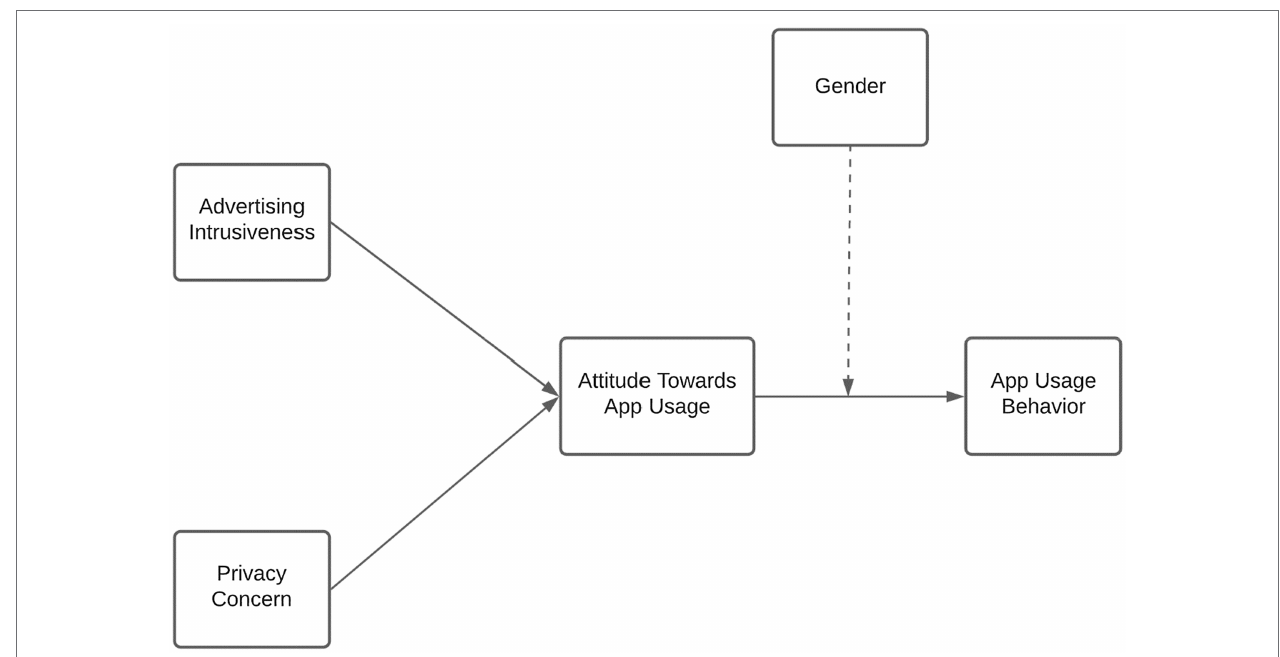
FIGURE 1 | The framework of the